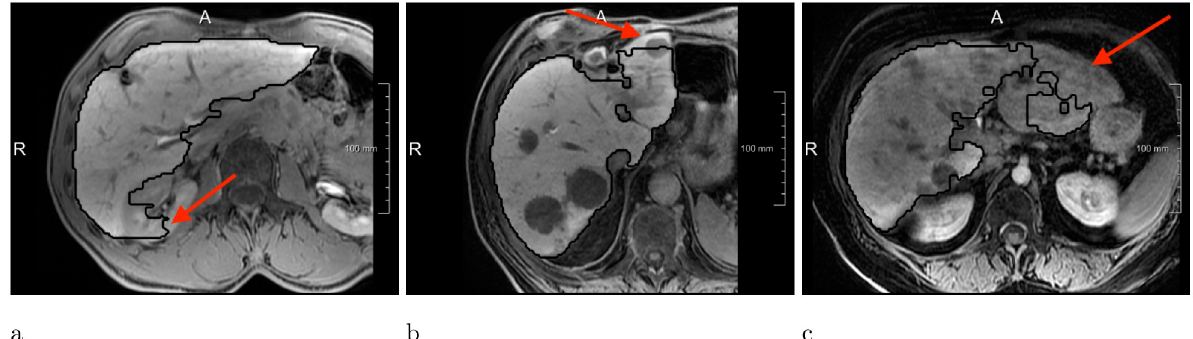
Fig 8. Most common error types of the Liver-Net approach. (a) Leakage into surrounding structure of similar image intensity. (b) FNs due to lesions located near the organ boundary. (c) Liver underestimation caused by a big inhomogeneous lesion.